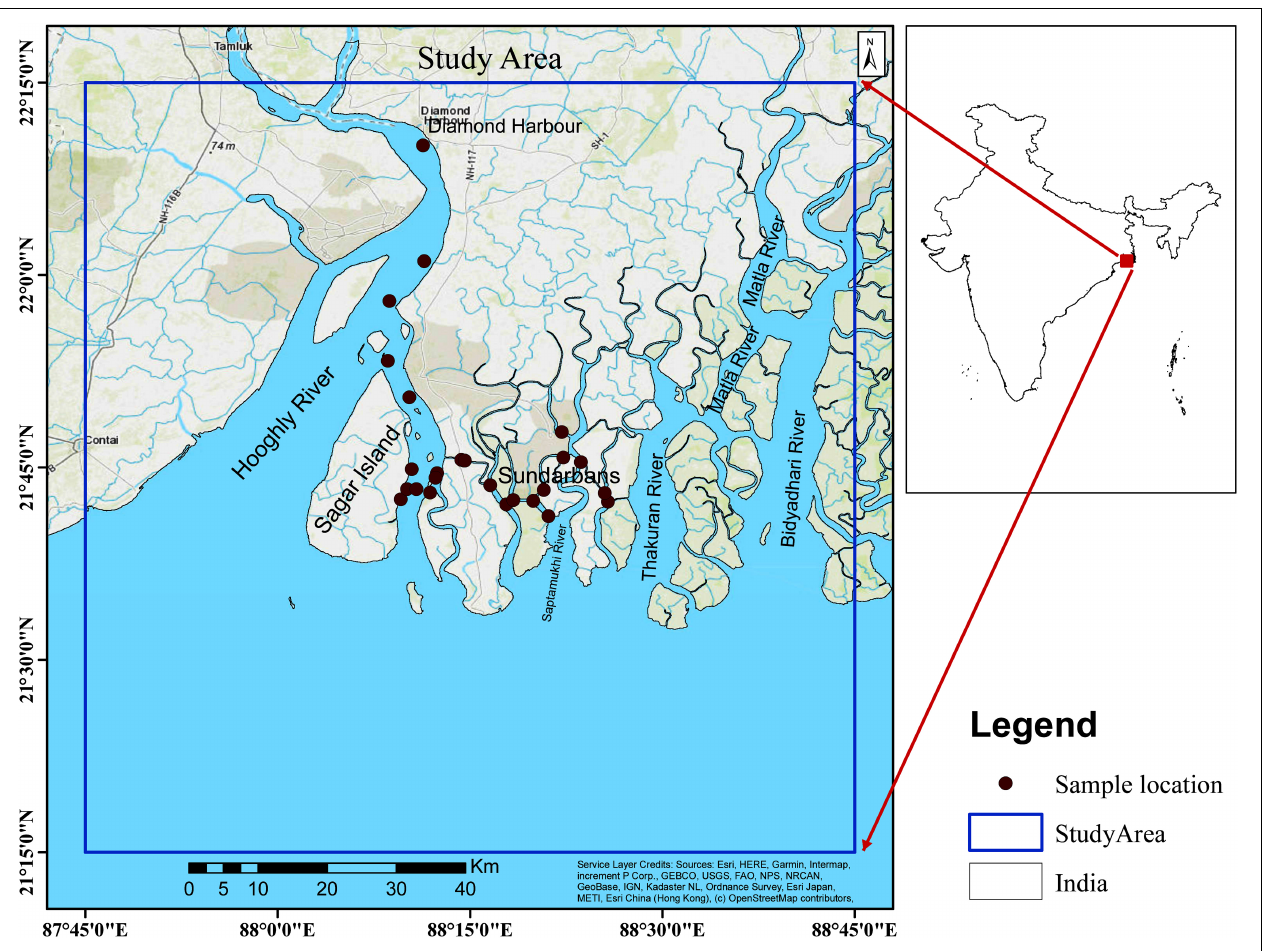
FIGURE 1 | Map showing the location of the study region (inset) in the northern Bay of Bengal. Red dots indicate the locations of the in situ total suspended matter (TSM) observations during December 9–11,